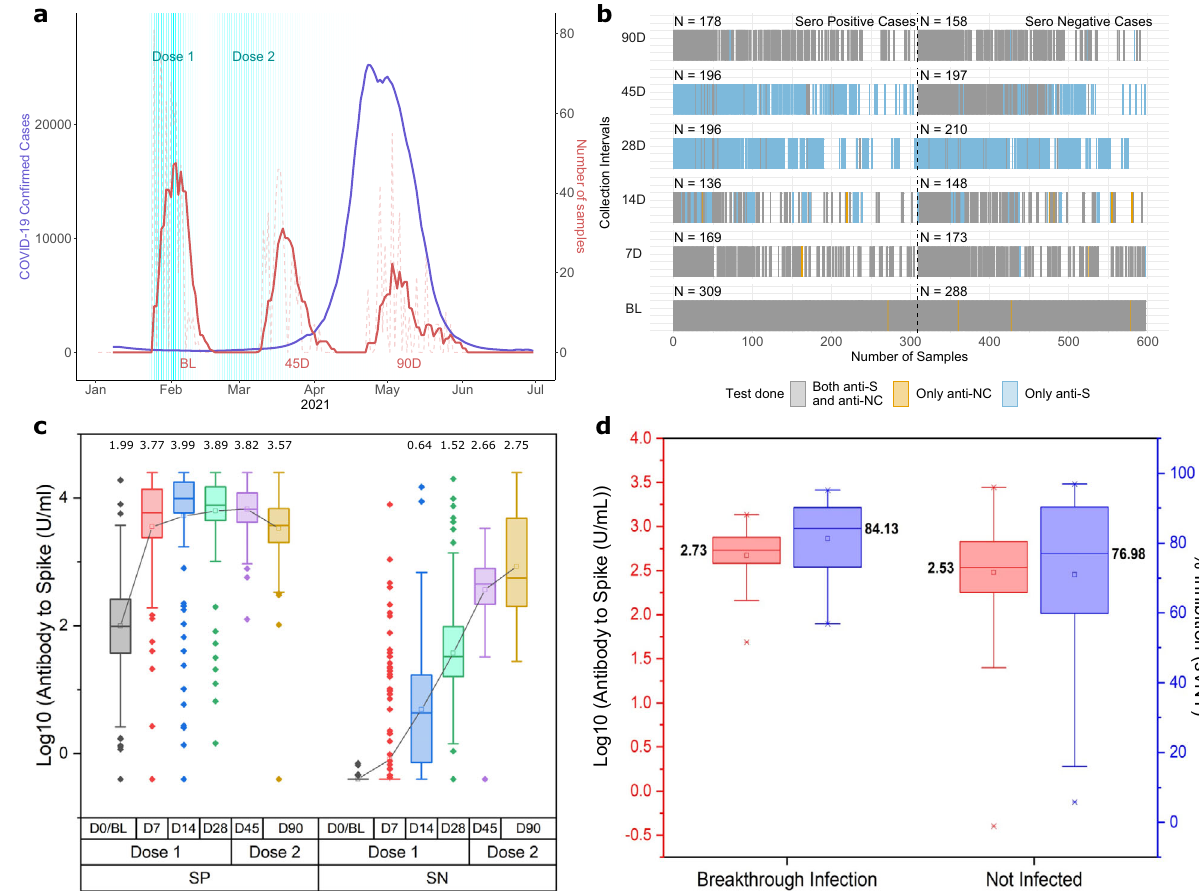
Fig. 1 Time period of sample collection and structure of HCW Cohort with Antibody response and kinetics. a Time distribution of sampling for HCW cohort shown alongside the Delta-variant driven surge (April, May 2021). Sample collection is 7 days moving average for HCW cohort. b Data Structure of the cohort and sampling. c Antibody to spike protein in log 10 units (U/ml) at baseline (D0/BL) and 7, 14, 28,45, 90 days after fi rst dose in baseline antibody naïve (SN) and infection recovered (SP) subjects. Second dose precedes D 45 and D 90 (Number of Samples; For SP at D 0 = 308, D 7 = 162, D = 130, D = 175, D = 103, D = 149 and For SN at D = 281, D = 163, D = 133, D = 196, D = 123, D = 112), Box plot is 25 – 75 range box, with 14 28 45 90 0 7 14 28 45 90 median line and the square is mean. Whiskers are set at outliers with a coef fi cient of 1.5. d Antibody to Spike in log 10 units (U/ml) and % Inhibition (sVNT) response for breakthrough cases and non-infected subjects after two doses of vaccine in D 0 (Baseline/BL) antibody naïve individuals ( n = 24 for breakthrough infection group for both anti-S and sVNT and n = 71 for not infected group for both anti-S and sVNT). Box plot is 25-75 range box, with median line and the square is mean. Whiskers are set at outliers with a coef fi cient of 1.5 and cross shapes below and above whiskers are 1 and 99 percentile